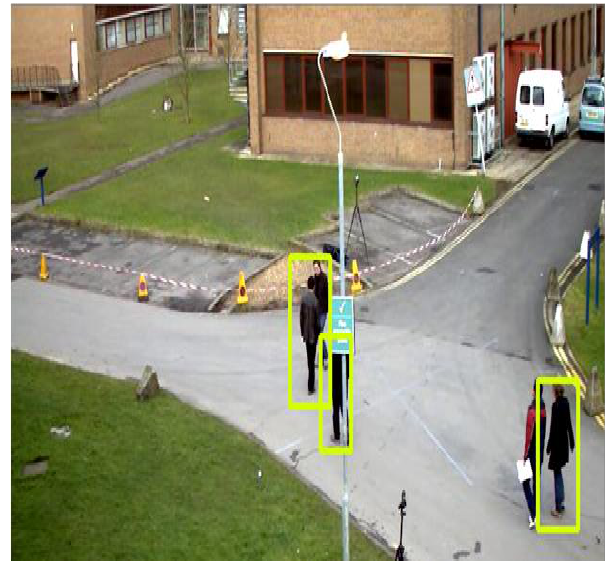
Figure 7. When user selects pedestrian’s detection (ref. Figure 4).